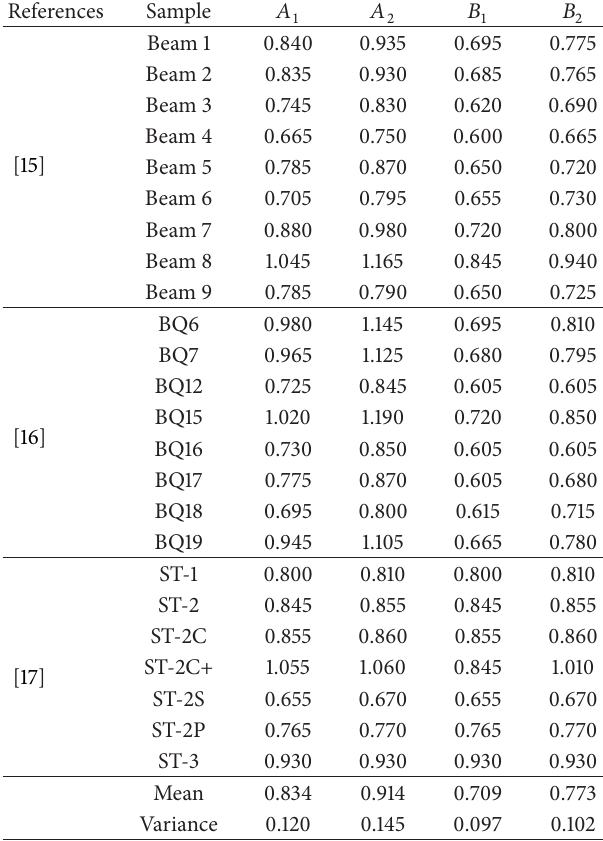
/ 𝐹 for the reference cal test